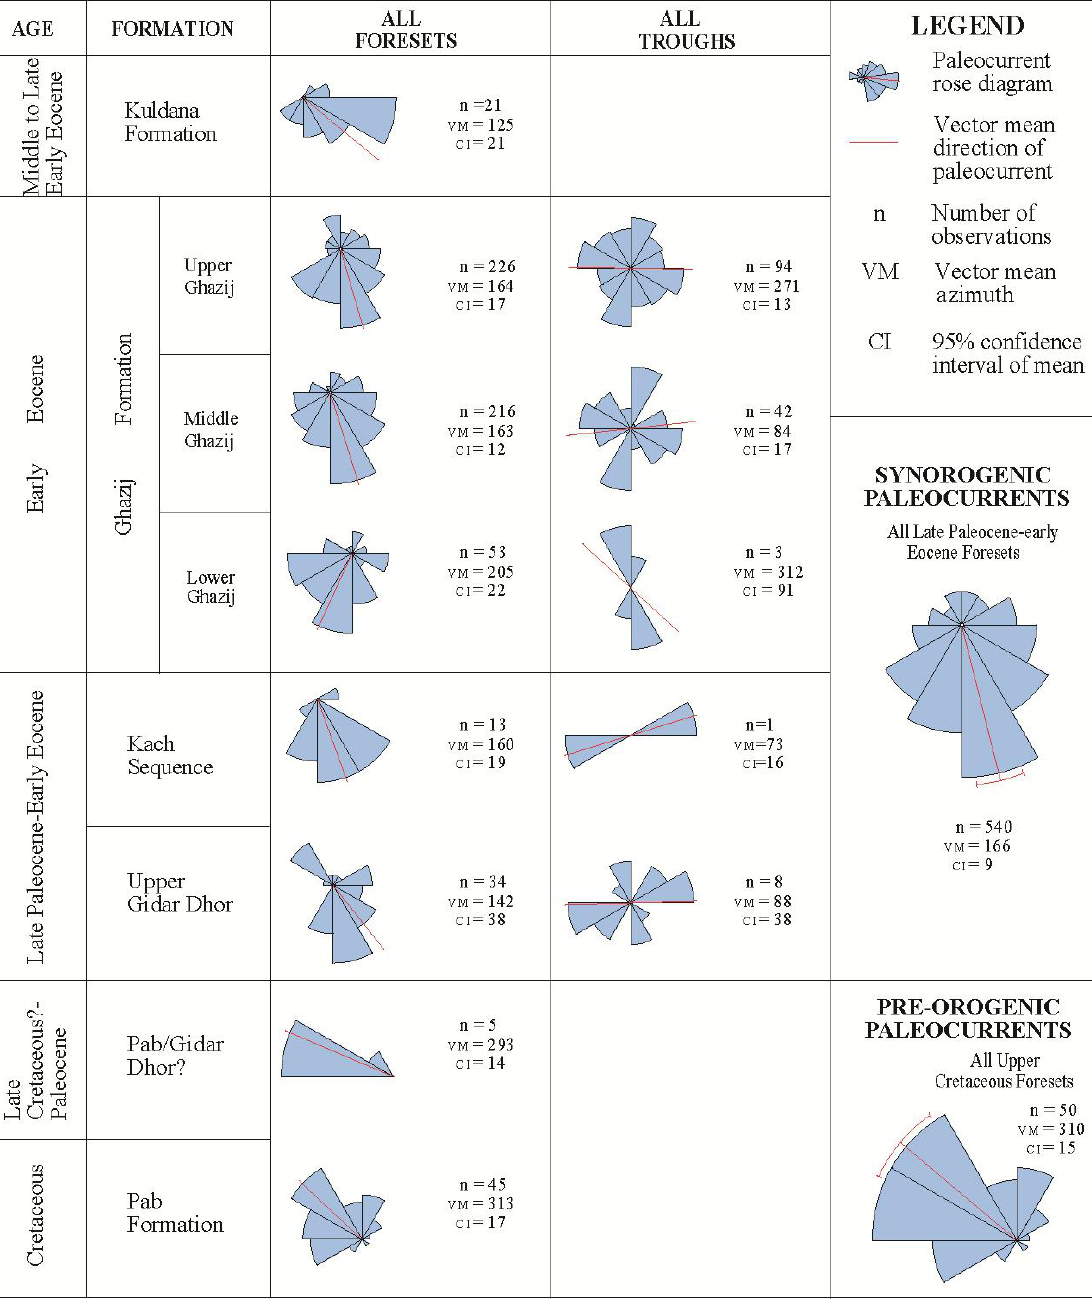
A total of 258 foreset and trough paleocurrent measurements were recorded from the middle part of the Ghazij Formation at various localities of the Kalat, Quetta, and Loralai regions (Table S1). The paleocurrents here show dominant south-southeastward flow with variation towards the east-northeast and south-southwest (Figures 4 and A6). Overall, in the area south of the Quetta syntaxis, the vector mean paleoflow directions of both Kalat and Quetta regions indicate a very consistent